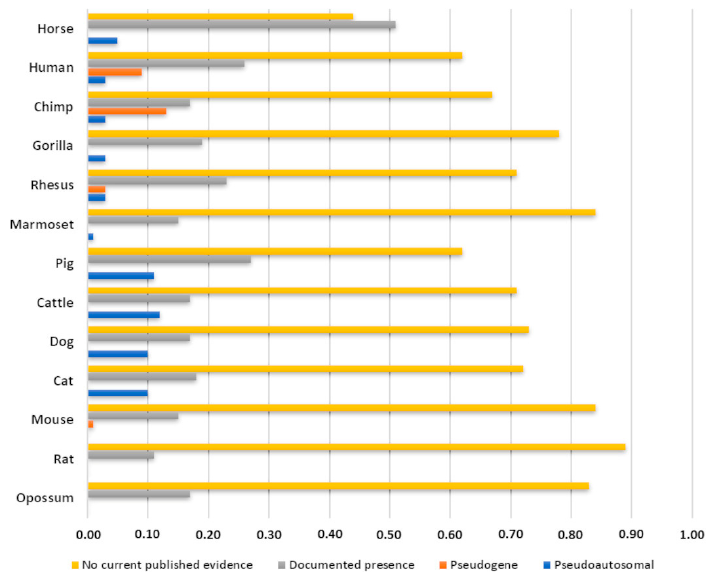
Figure 1. Rate of MSY gene data for 13 mammalian species available in 2018 when the horse Y chro‑ mosome assembly was released. Details and comparison were described in [93]. Each bar represents the amount of MSY coding genes, pseudogenes and transcripts known (or not) in horses and other eutherian species with sequenced or partially sequenced MSYs. See also Table S1. The conservation of equine MSY was at higher level [93] than that previously ob- served in primates [96,97]; indeed, even though the divergence time between horse and donkey [114] is comparable to that between human and chimpanzee [96], they show sig- nificantly different evolutionary rates in the MSY. Horse and donkey retain the same sin- gle-copy MSY and multi-copy sequences [93,113], while more than 30% of human and chimpanzee MSY genes are not homologous and differ in gene content [96]. 3. The Debate about Stallion Pedigrees In contrast to the high mtDNA variability reported in previous studies [2,8,9,115,116], which was already present immediately after their domestication [17,19,117], the Y chro- mosome shows a very low level of genetic polymorphism in modern horse populations [91,118]. Despite a large diversity of domestic male founders contributing to their early domestication [117], the Y chromosome variability considerably decreased in the last 200 years because of selective pressures and the reduction in the stallion population size op- erated by breeders [19]. It is known that Thoroughbreds in particular were widely used in the development of many breeds to obtain a less bulky and lighter horse more suitable for riding [119]. Due to the intensive selection of stallions, the establishment of a studbook-mediated sire line represents the main cause of this lack of Y-chromosome variation. The importa- tion of stallions used to improve autochthonous breeds started from the Arabian region,